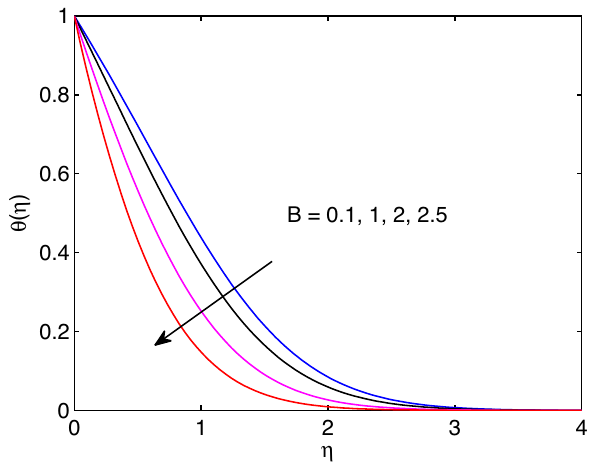
Figure 7. Melting heat transfer effects on temperature profiles.